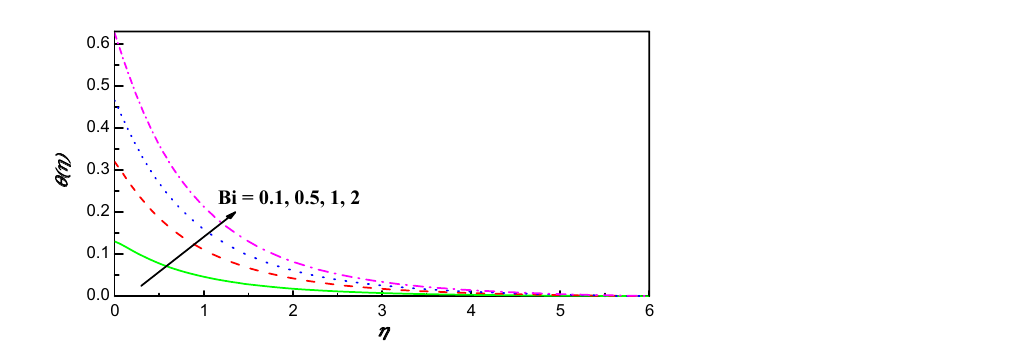
Figure 8. θ(η) variation vs. Bi